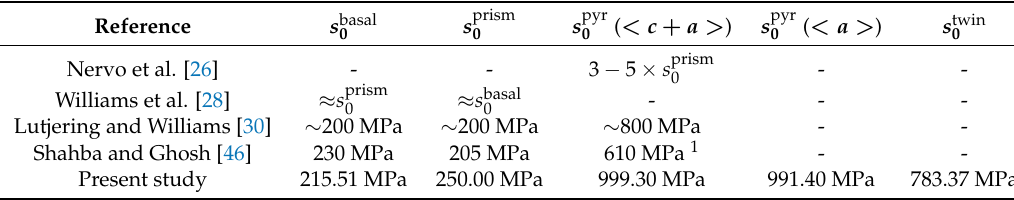
Table 3. Critical Resolved Shear Stress (CRSS) values of different slip systems in Ti-7Al.